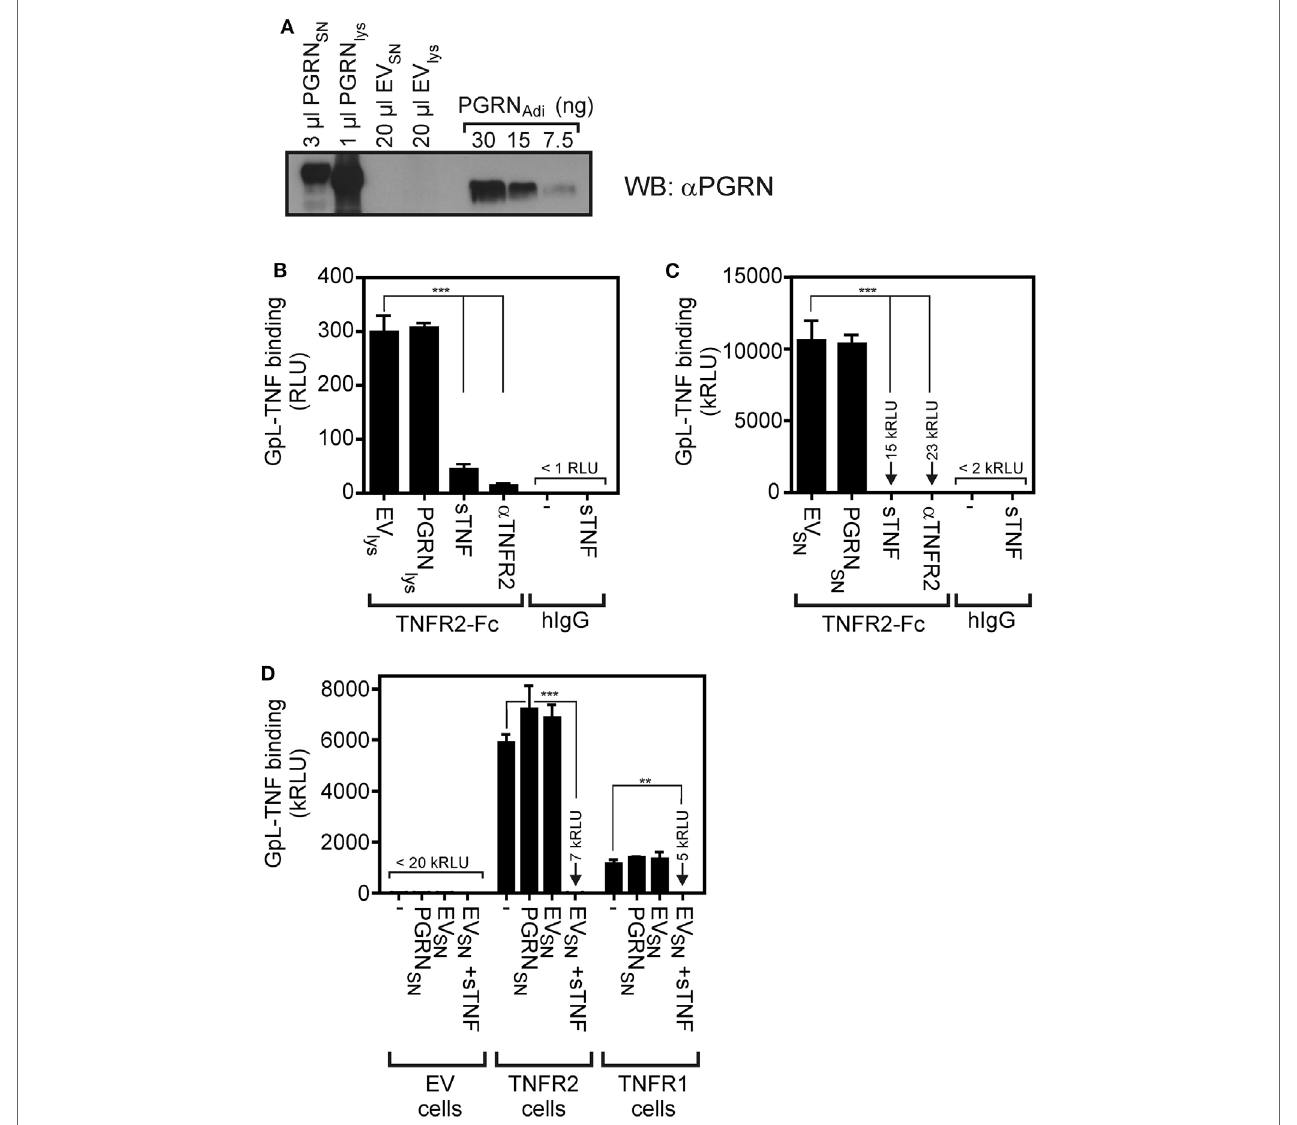
FigUre 2 | Preincubation with untagged human embryonal kidney cells 293 (HEK293) cell-derived progranulin (PGRN) does not interfere with tumor necrosis factor (TNF)-tumor necrosis factor receptor-1 (TNFR1) and TNF–TNFR2 interaction in cell-free and cellular binding studies. (a) HEK293 cells were transfected with empty vector (EV) or an expression plasmid encoding non-tagged PGRN. The indicated volume of supernatants (SNs) and cell lysates derived from these transfectants along with recombinant PGRN Adi (30, 15, and 7.5 ng) as standard were analyzed by Western blotting for the presence of PGRN and estimation of PGRN concentration. PGRN concentrations reached approximately 10,000 ng/ml in the SN of PGRN transfected cells (PGRN SN ) and approximately 30,000 ng/ml in the corresponding cell lysate (PGRN lys ). There was no detectable endogenous PGRN expression neither in the SN (EV SN ) nor the lysate (EV lys ) of EV-transfected cells. (B,c) TNFR2-Fc or, as a control for unspecific binding, IgG1 was immobilized to black enzyme-linked immunosorbent assay plates. Lysates (B) and SNs (c) of PGRN and EV-transfected cells [PGRN lys and EV lys (B) , PGRN SN and EV SN (c) ] were added for 1 h before the specific binding of 50 ng/ml and GpL-TNF was determined in triplicates. Where indicated immobilized TNFR2-Fc was pretreated for 1 h with 2,000 ng/ml sTNF or 20 µg/ml of a neutralizing TNFR2-specific antibody ( α TNFR2). (D) HEK293 transfectants expressing TNFR1 or TNFR2 along with control HEK293 cells transfected with EV were preincubated for 1 h with pure